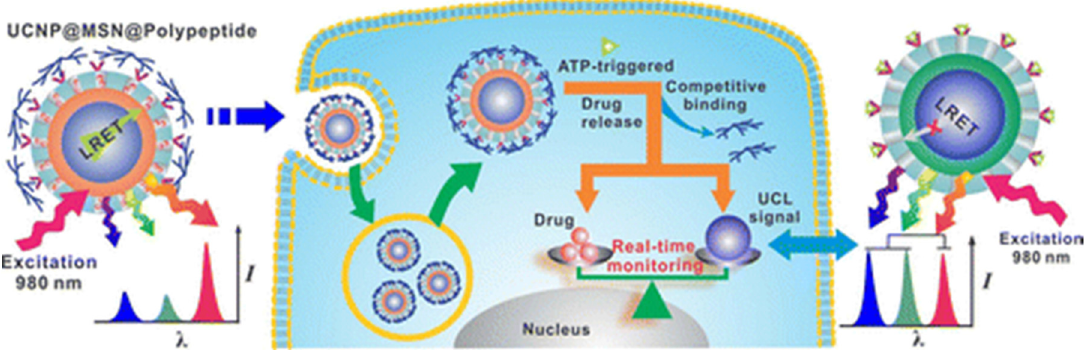
Figure 13. Scheme of real-time monitoring of ATP-responsive drug release